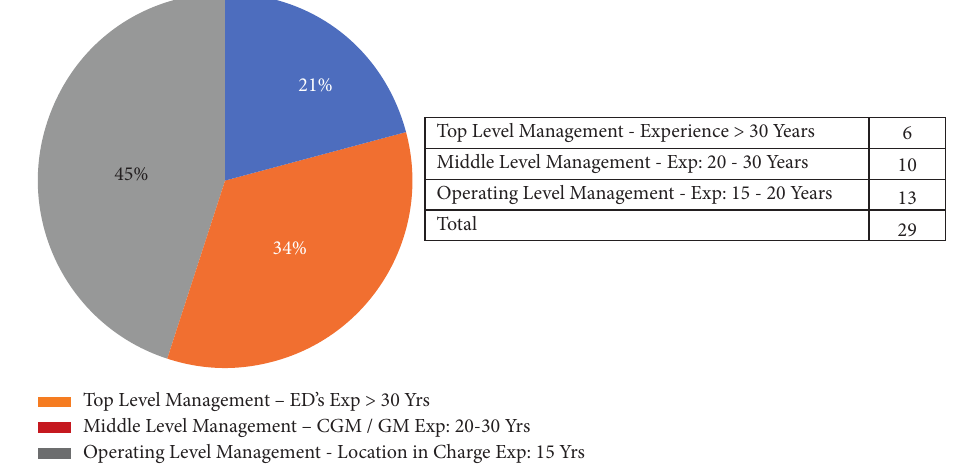
Figure 3: Data collection stages for survey